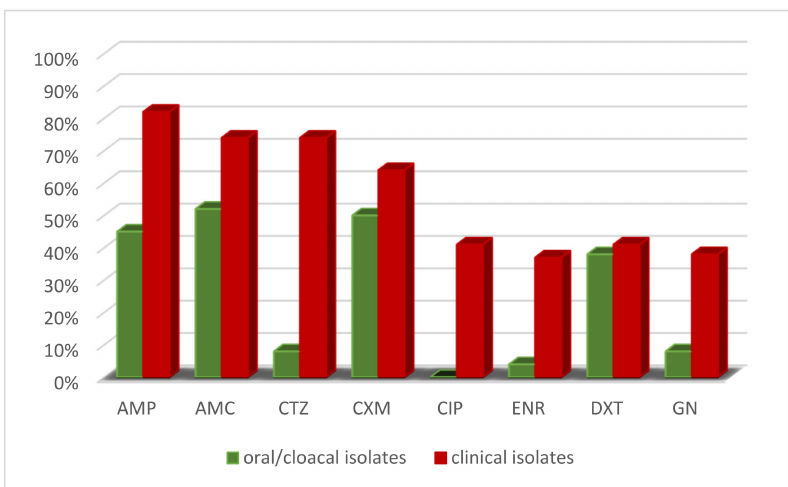
Figure 4. Percentage of AMR of O/C isolates vs. clinical isolates. AMP: Ampicillin,